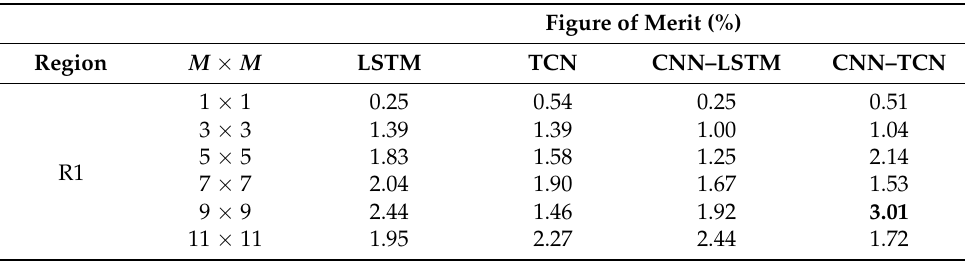
Table 4. Figure of merit (FOM) values obtained for (R1) the Regional District of Bulkley-Nechako, (R2) the Regional District of Central Kootenay, (R3) the Northern Rockies Regional Municipality, and (R4) the Cariboo Regional